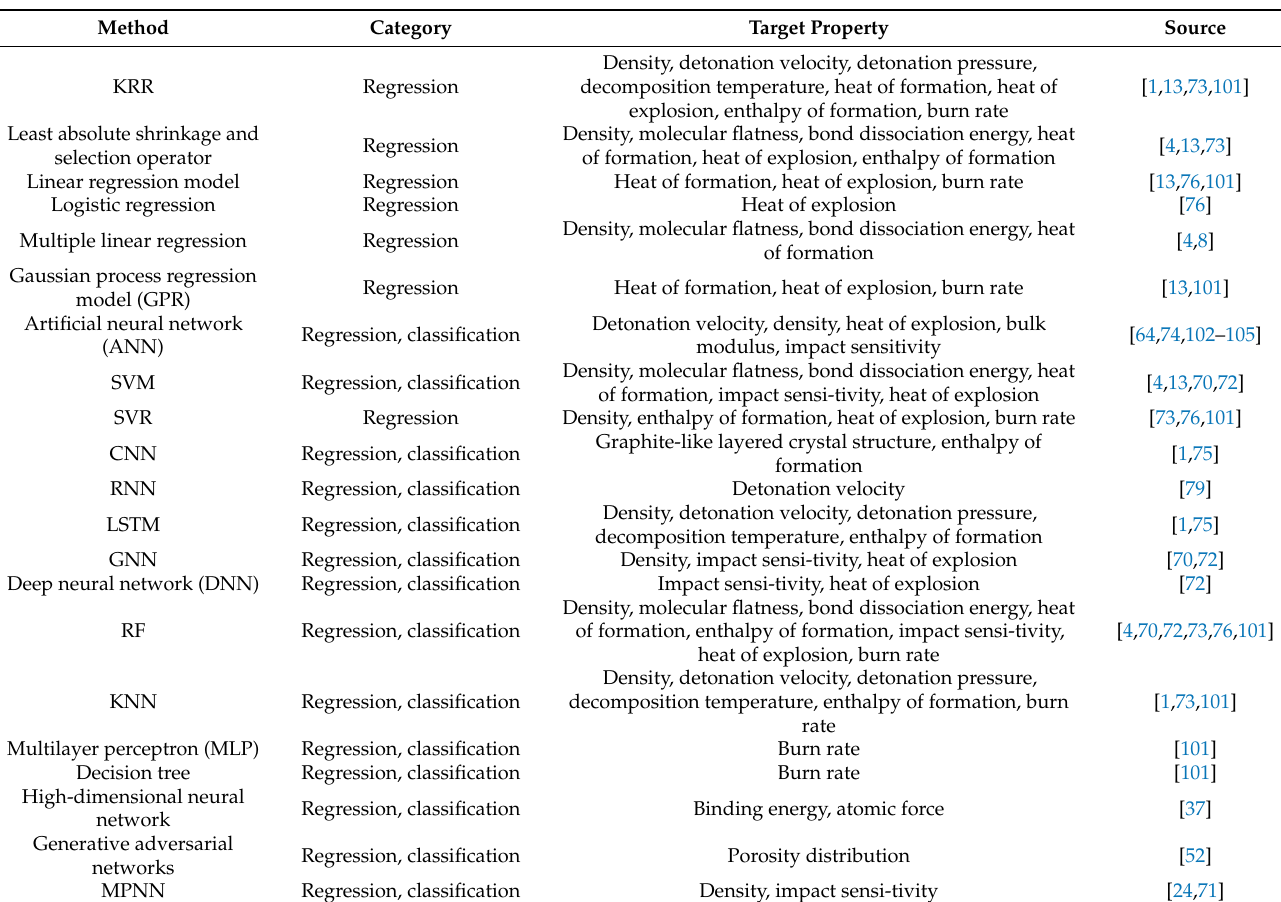
Table 3. A list of important ML methods in the